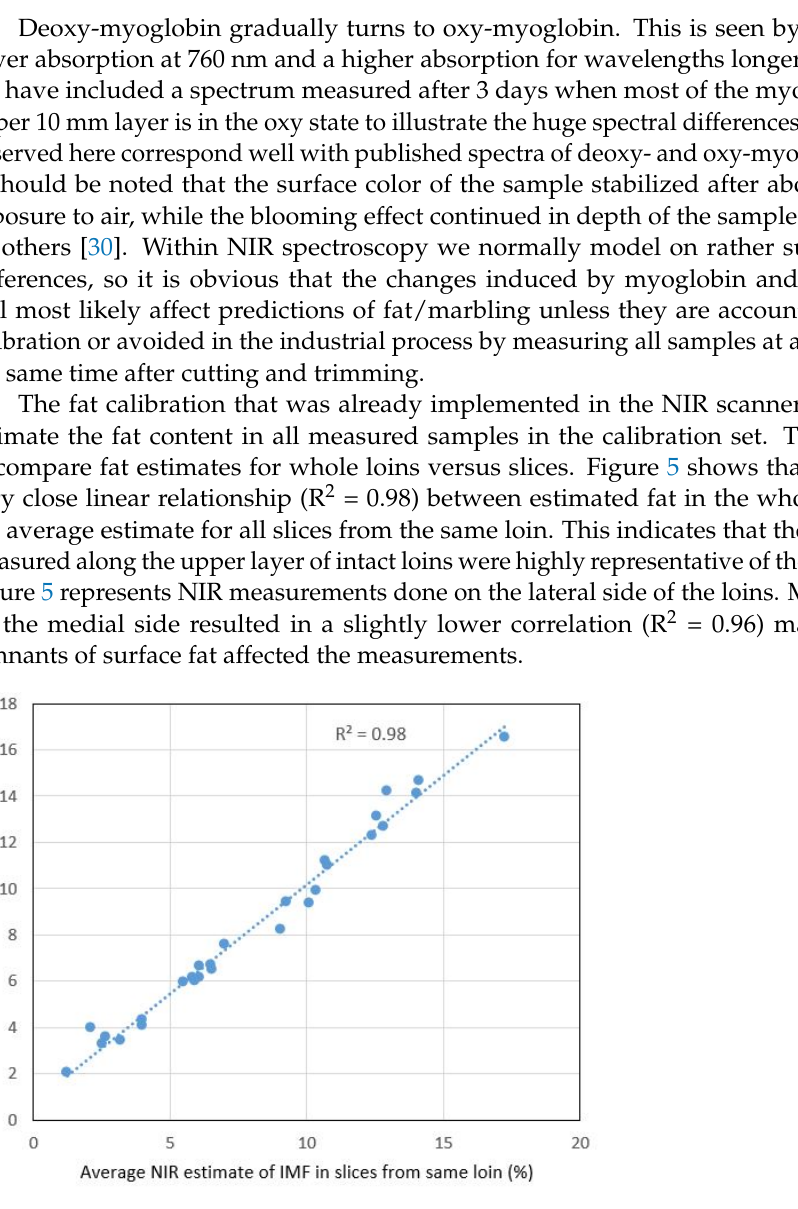
( c ) Figure 4. ( a ) NIR calibration spectra from loin slices. Colorbar indicates marbling scores for the slices. ( b ) NIR spectra from light and dark beef, including difference spectrum. ( c ) Spectral effects of blooming — oxygenation of myoglobin.